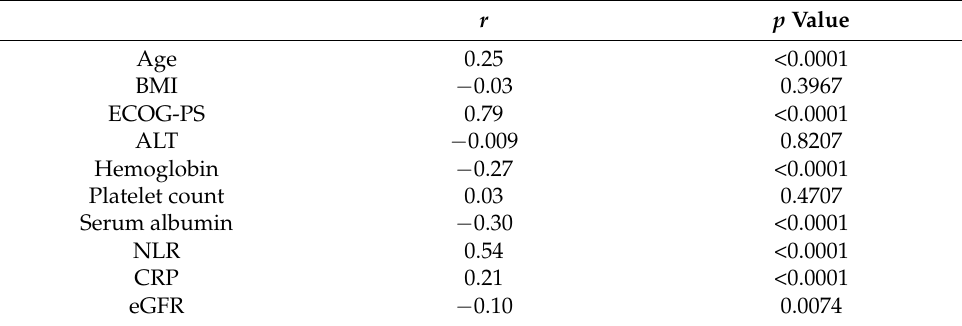
Table 2. Correlation in the SARC-F score and baseline characteristics.